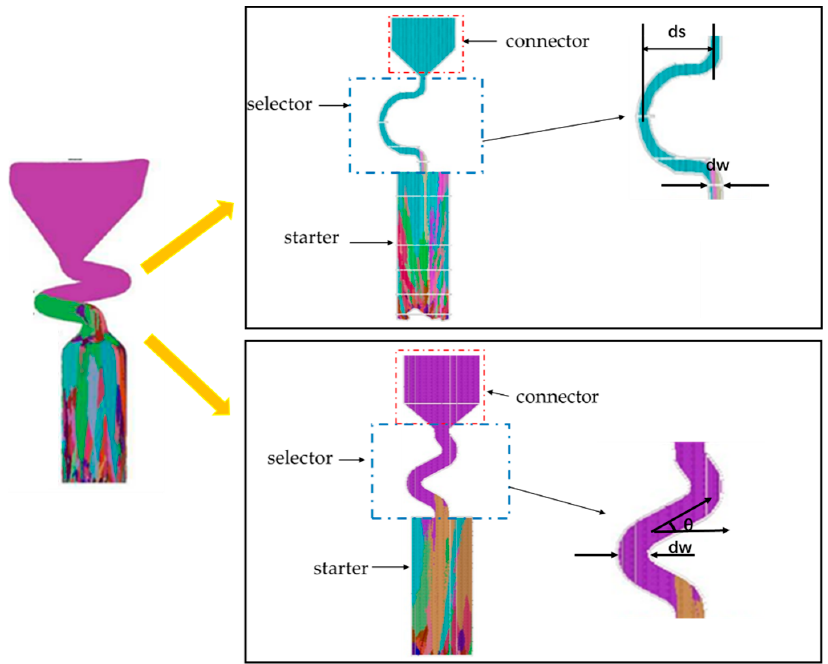
Figure 1. Schematic drawings of C-type and Z-type and the parameters used in the selector part. The main steps are divided into several sub-steps.